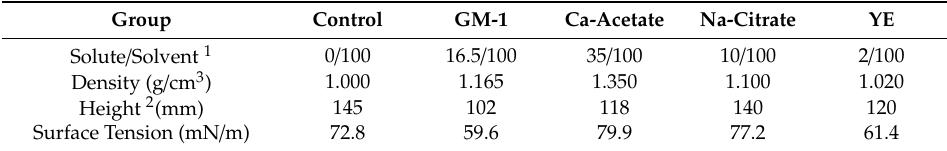
Table 4. E ff ects of growth media on surface tension of saturated